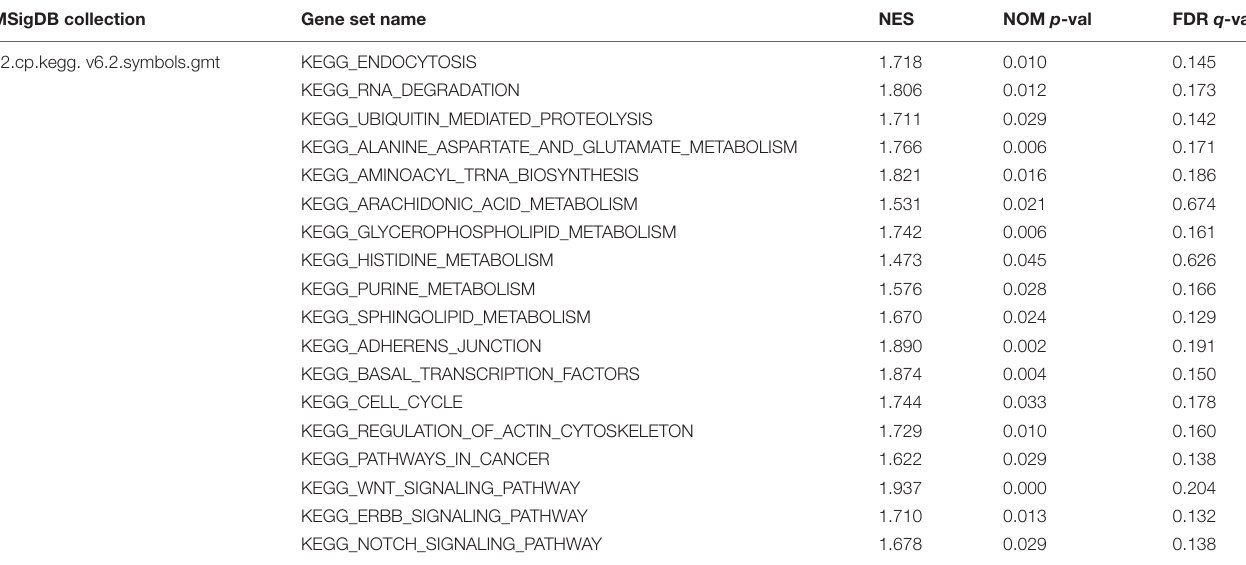
TABLE 5 | Gene sets enriched in phenotype high and low. MSigDB collection